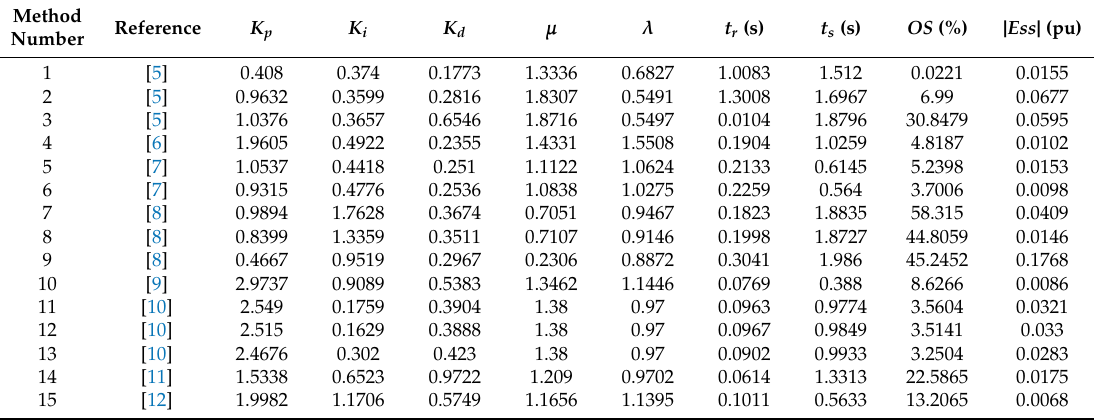
Table 3. FOPID parameters and transient response parameters from the literature.